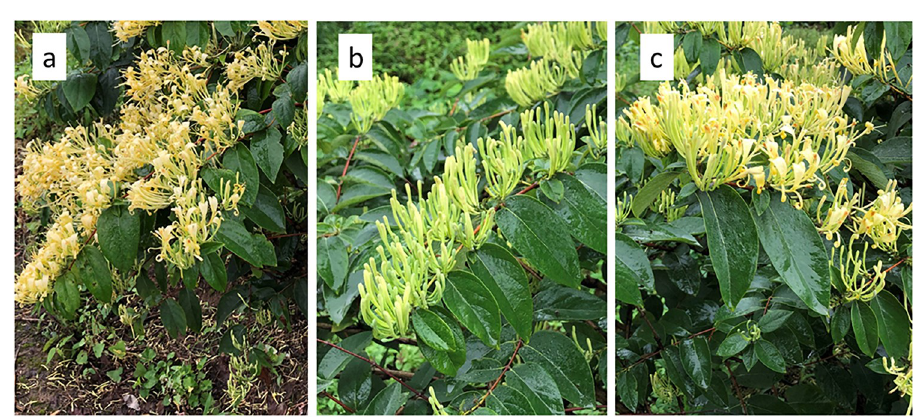
Fig 1. Image shows the different types of Lonicera . macranthoides Hand.-Mazz ( L . macranthoides ). (a): The flowering type (Ft). (b): The closed bud type (Bt). (c): The MeJA-treated closed bud type